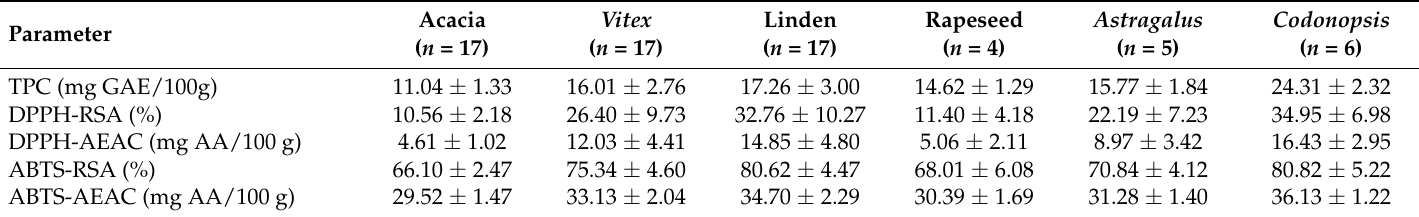
Table 5. Antioxidant properties of different honey